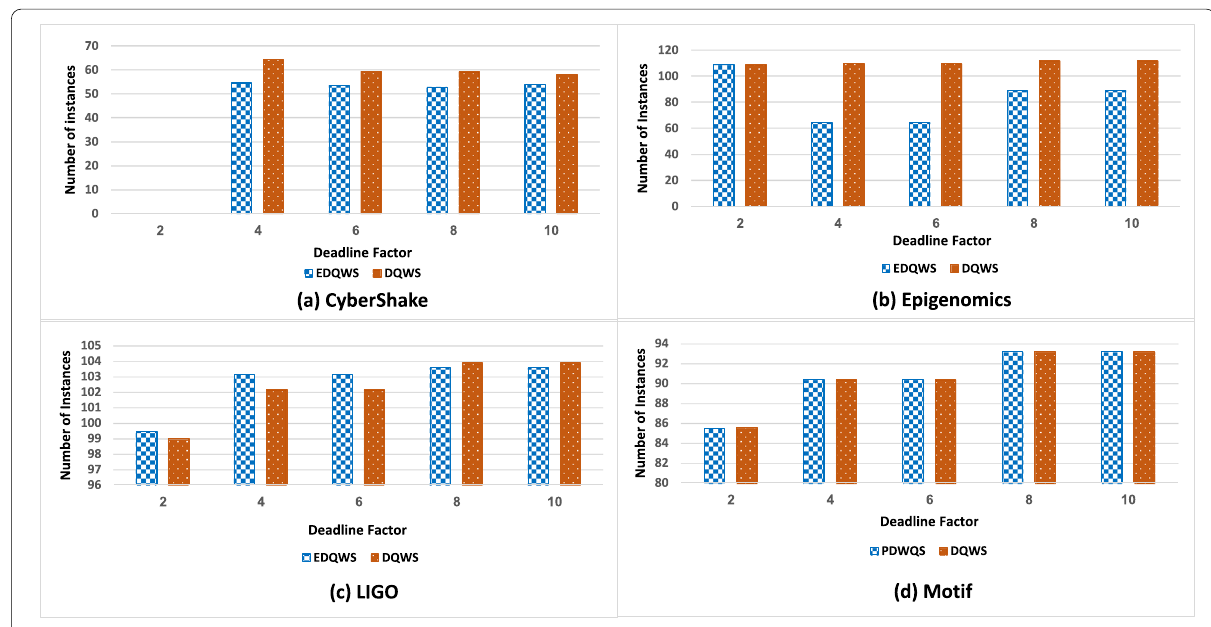
Fig. 13 Number of Instances vs. Deadline Factor for four different workflow